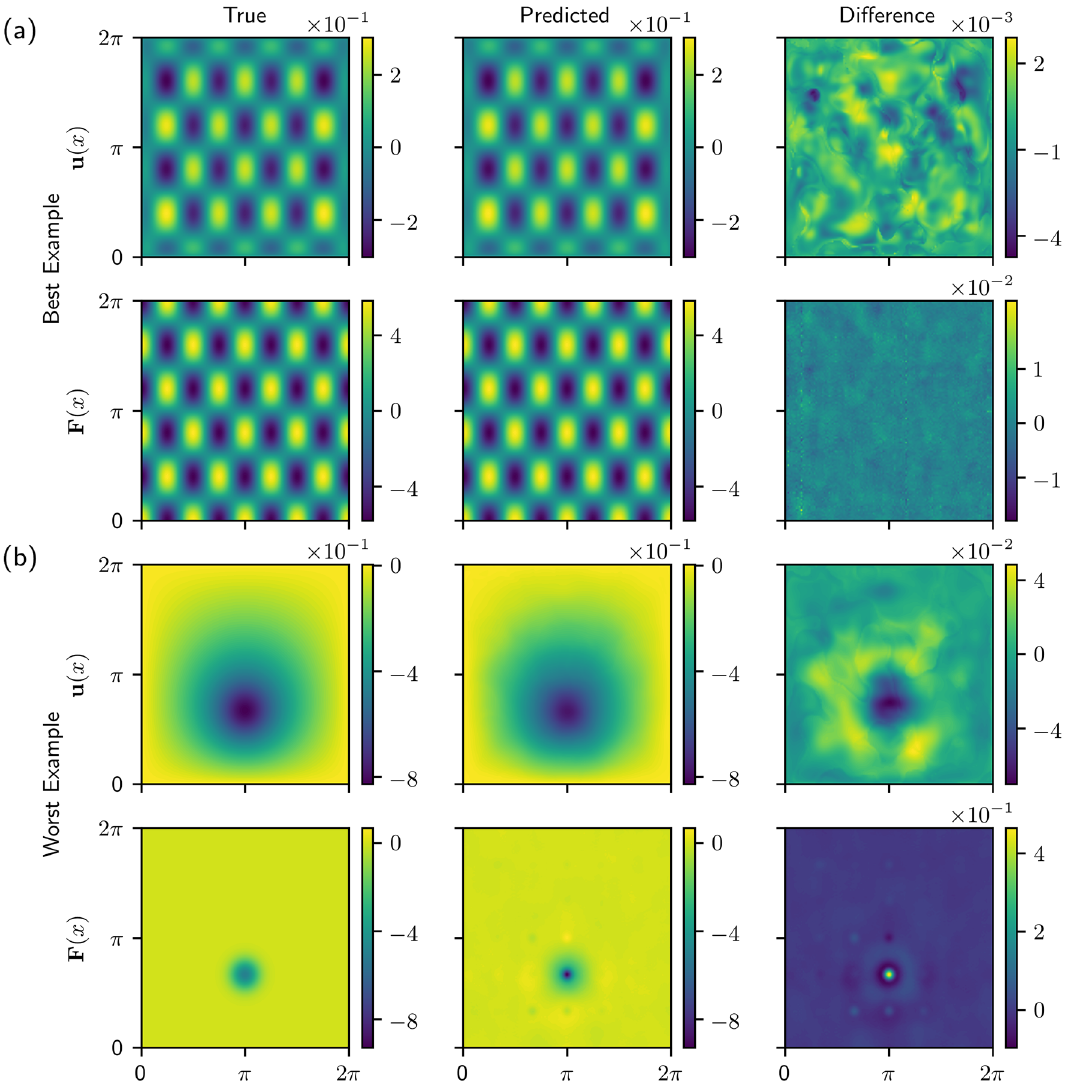
Figure 4. Model predictions for the ( a ) best and ( b ) worst examples from test data with Gaussian and cosine forcings. In both ( a,b ), the top row shows the true solution u ( x ) , the predicted solution using the Green’s function, and the difference between the true and predicted solution. The bottom row shows the true forcing function F ( x ) , the predicted forcing function, and the difference between the true and predicted forces. In order to account for the difference in scale between u ( x ) and F ( x ) , the differences are scaled by the infinity norm of the true solution or forcing function ( Difference = ( True − Predicted )/ || True || ∞